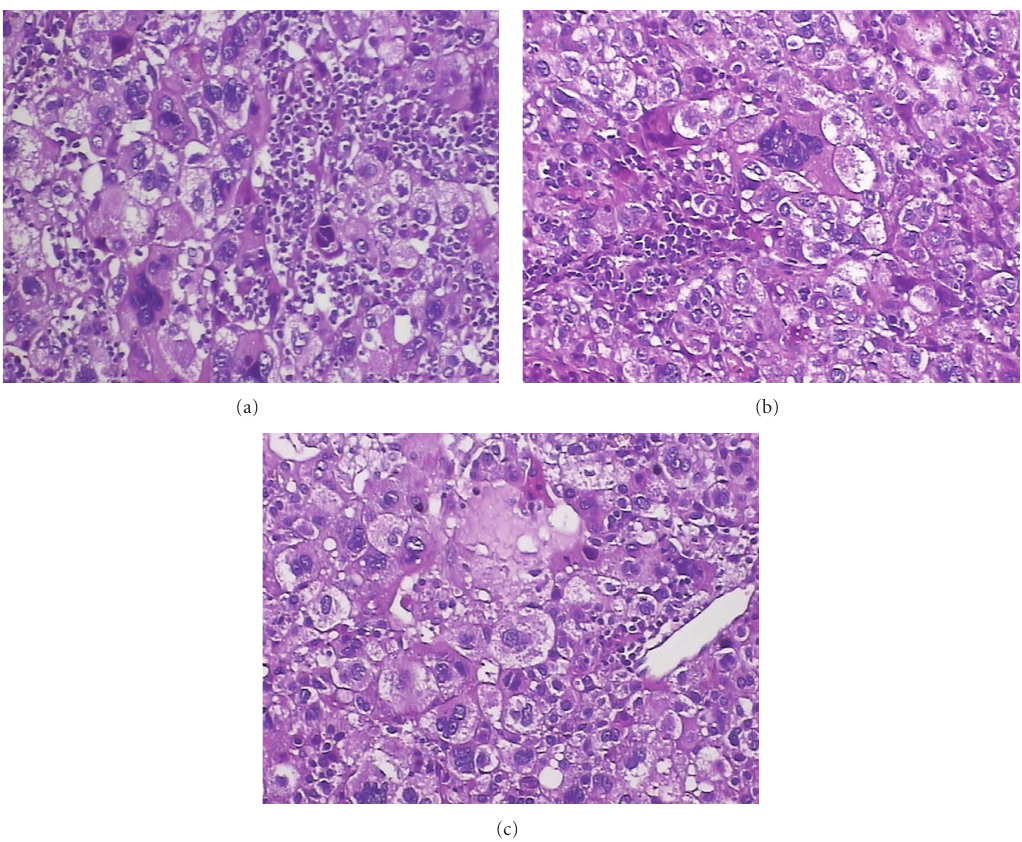
Figure 5: The infiltration of lymphocytes in the tumor from the mice ( × 100, H.E staining). The infiltration of lymphocytes was observed in the tumor section from mice treated with recombinant attenuated S. typhimurium strains. It showed that the number of lymphocytes was obviously more in the tumor from TPI group (a) than in the tumor from TP (b) and TPG group